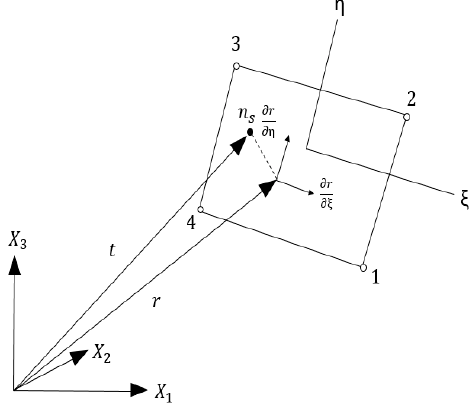
Figure 2. Location of contact point when n s lies on master segment.